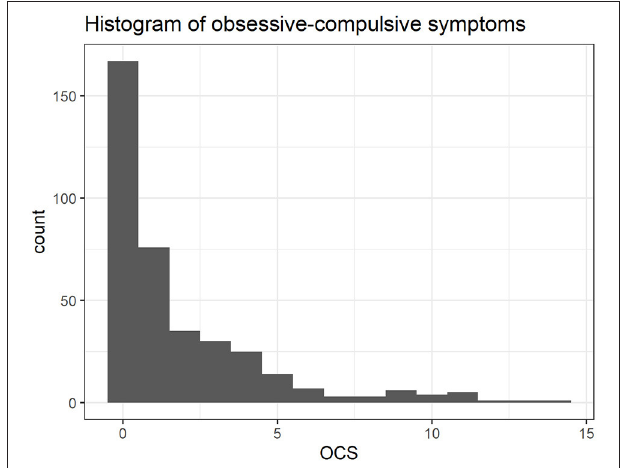
FIGURE 1 | Distribution of obsessive-compulsive symptoms (OCS) at